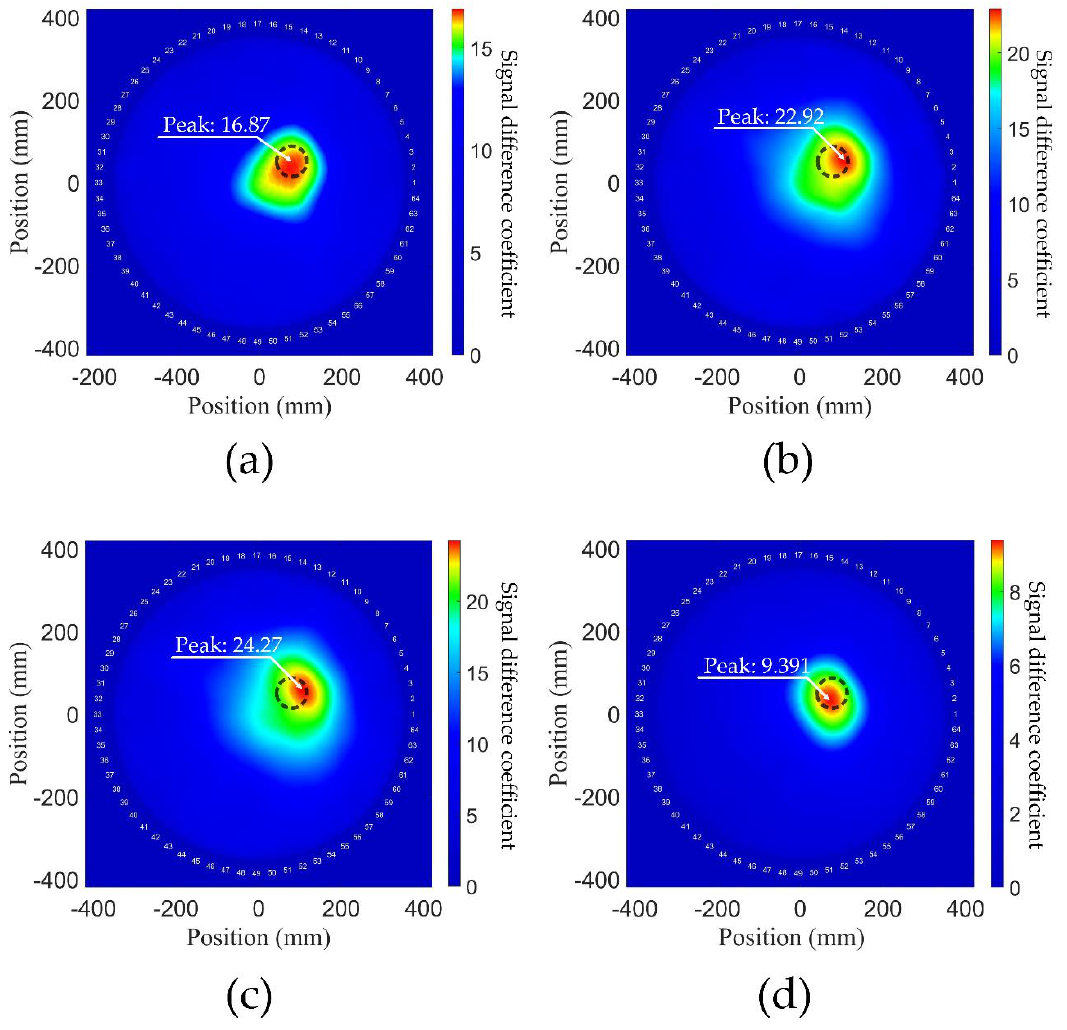
Figure 15. Probability distributions of the plasticine on the aluminum 6061-T6 plate in the laboratory reconstructed by ( a ) NGW method expressed with the second harmonics, ( b ) attenuation method, ( c ) MP method and ( d ) covariance method. The area covered by the circle corresponds to the positions of the plasticine in the experimental establishment.